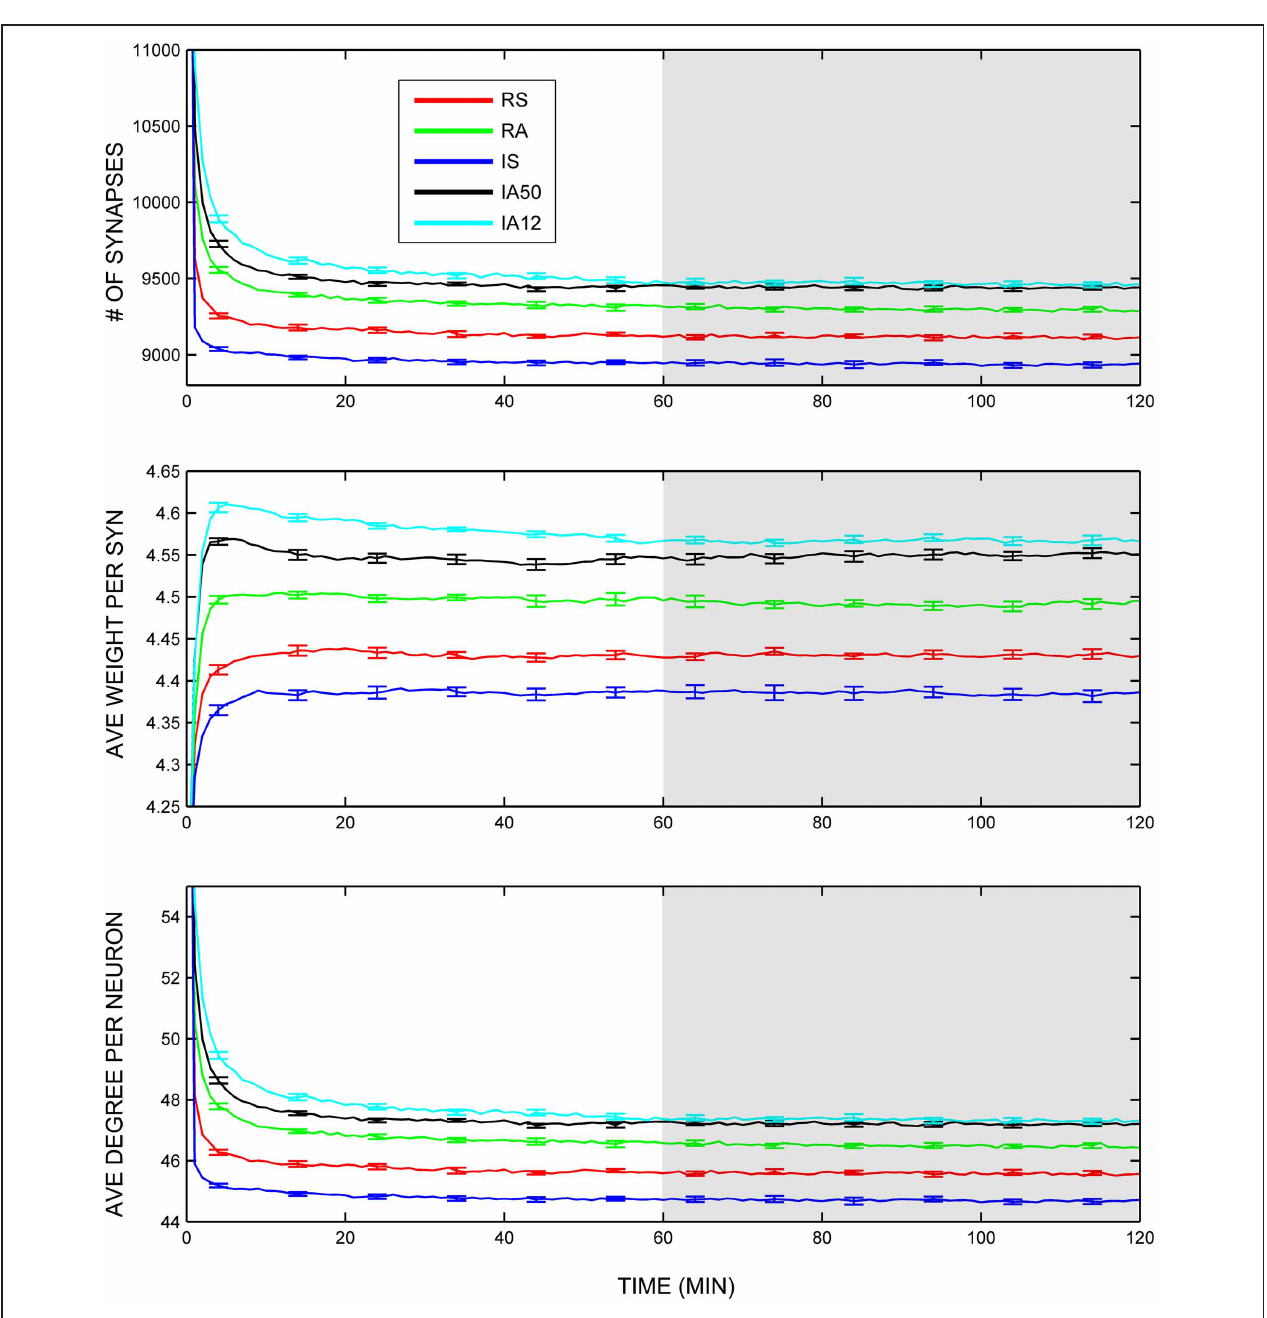
FIGURE 3 | Global variables. Trajectories of total number of excitatory synapses (top) , average synaptic weight (middle) , and average total neuronal degrees (bottom) across the entire simulation duration. Colored lines represent responses to separate external input regimes averaged across 10 simulations. Error bars represent S.E.M. across